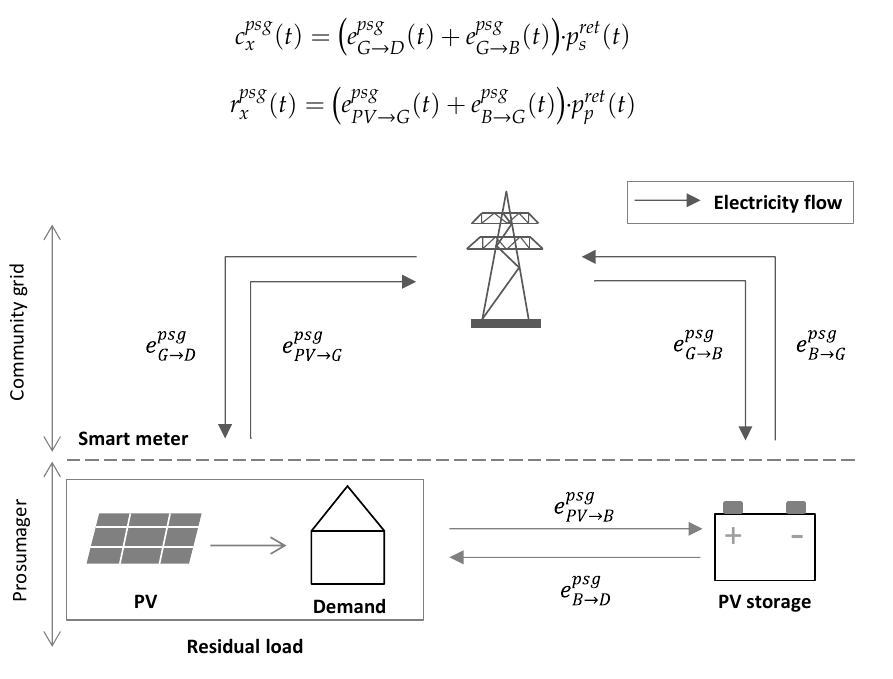
Figure 5. Schematic sketch of the prosumagers’ model.